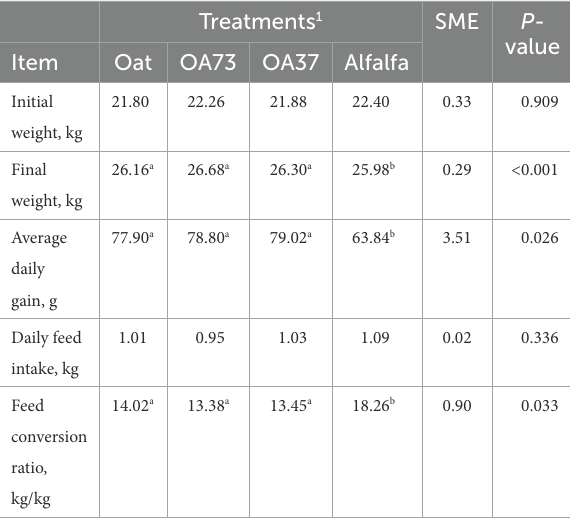
TABLE 2 Effects of oat and alfalfa on the growth of fattening